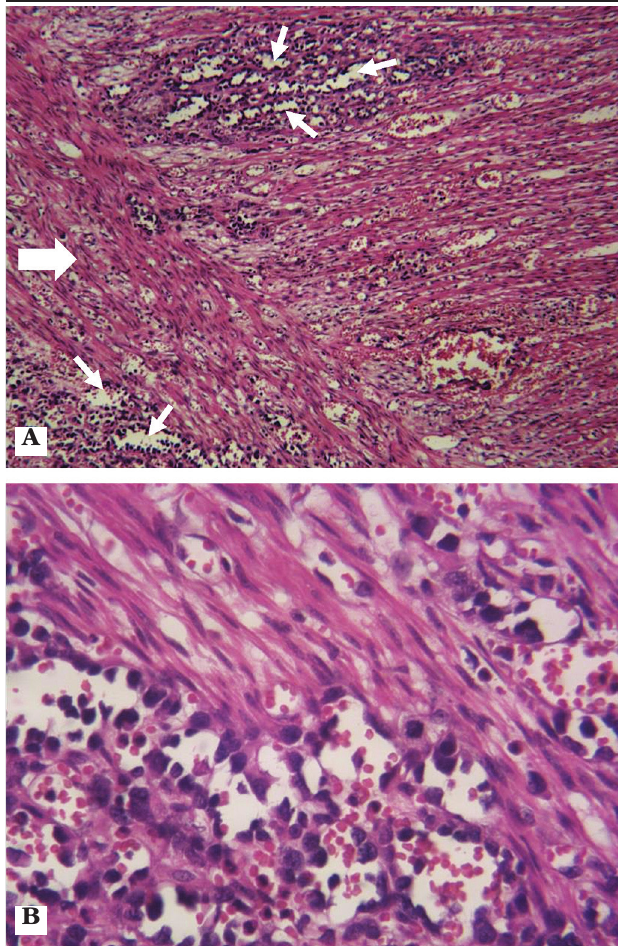
figurE 3 − Histological sections of intestinal neoplasm infiltrating muscular layer, observed through an optical microscope: A) neoplasm of vascular origin, invading muscular layer. One can observe muscle fibers (long arrow) and malformed vascular channels with atypical cells around them (short arrows) (HE, 100×); B) contrast between normal muscle cells and mesenchymal neoplastic tissue (HE, 400×) HE: hematoxylin and eosin.